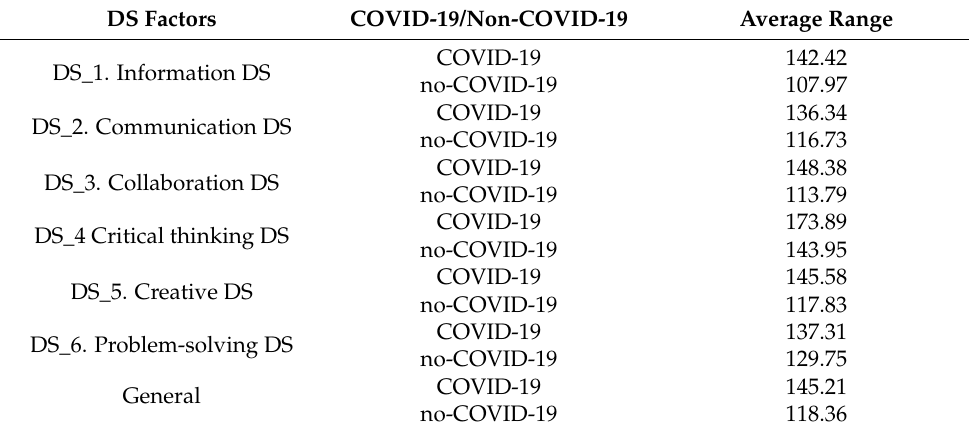
Table 9. Post-test average ranges by DS